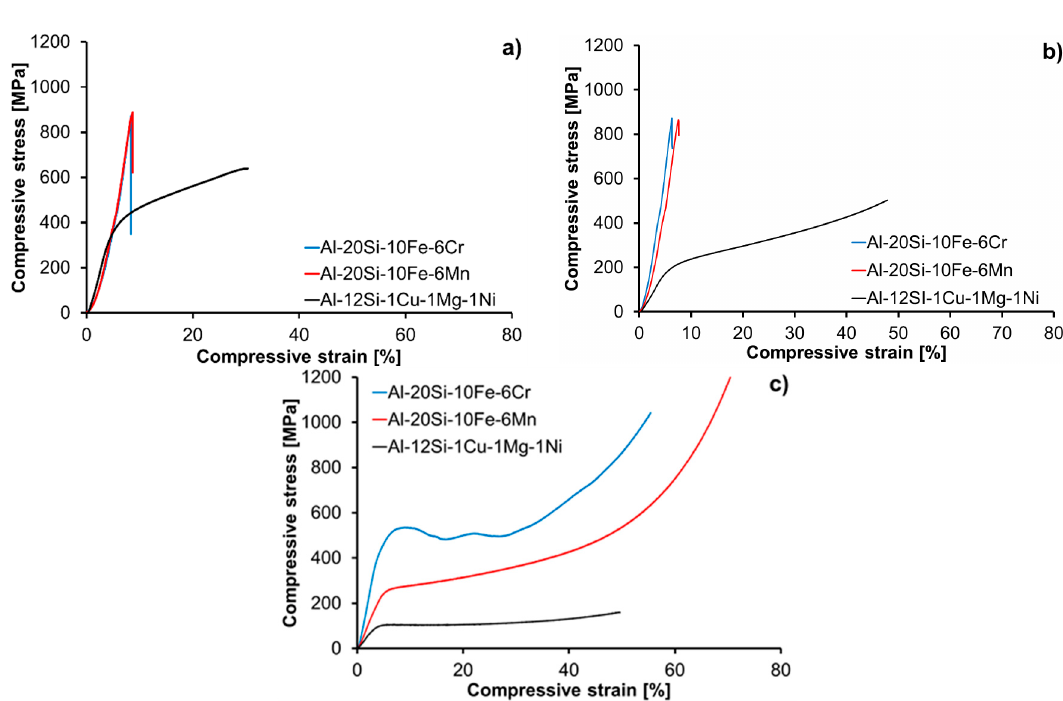
Figure 7. Compressive stress–strain curves of the MA + SPS alloys measured under different conditions: ( a ) laboratory temperature; ( b ) after 100 h of annealing at 400 °C; and ( c ) at 400 °C (10 min of tempering).